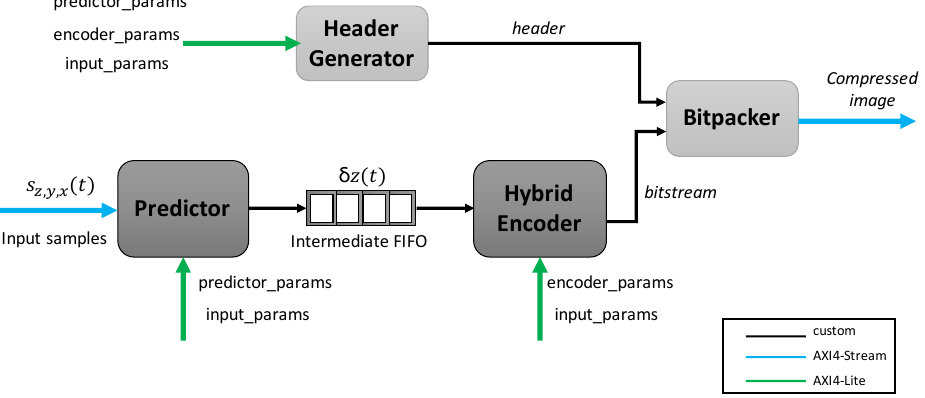
Figure 3. Top-level hierarchy of the HLS design.